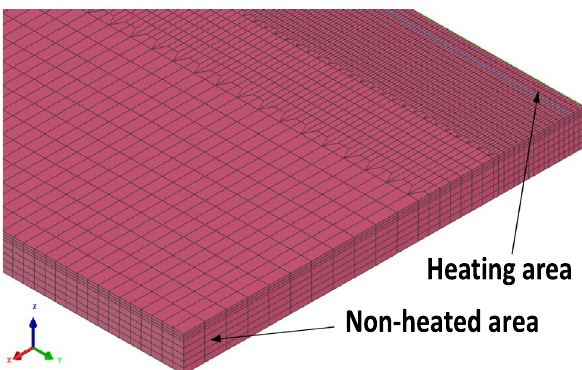
Figure 3. Plate finite element